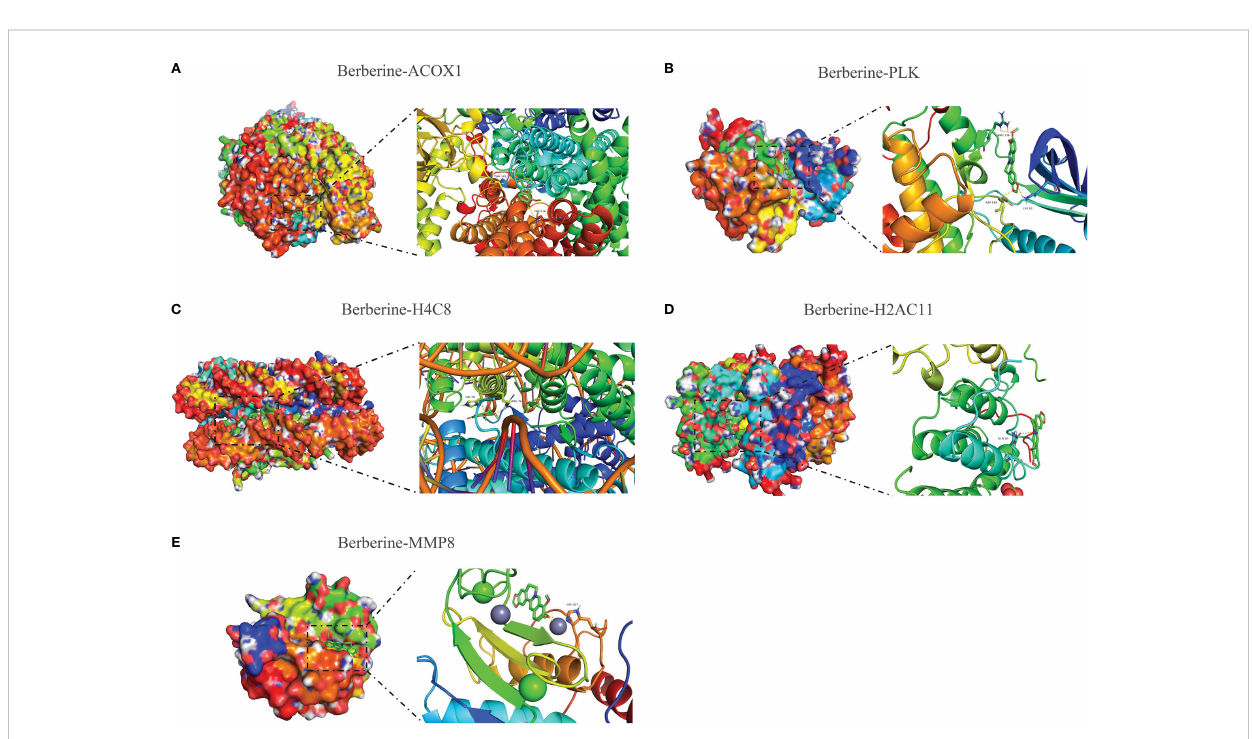
FIGURE 9 Molecular docking of berberine and target genes. The top 5 docking af fi nity score. (A) Berberine binding to ACOX1. (B) Berberine binding to PLK. (C) Berberine binding to H4C8. (D) Berberine binding to H2AC11. (E) Berberine binding to